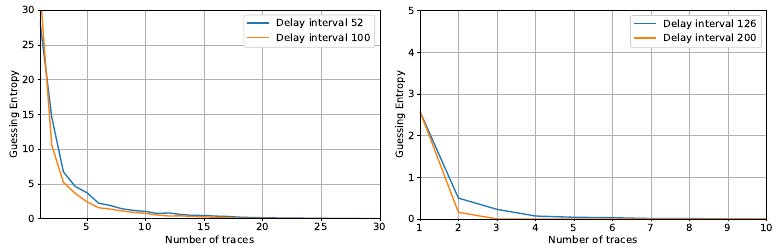
Figure 13: Guessing entropy of desynchronized datasets ASCAD v1 (left) and ASCAD v2 (right).